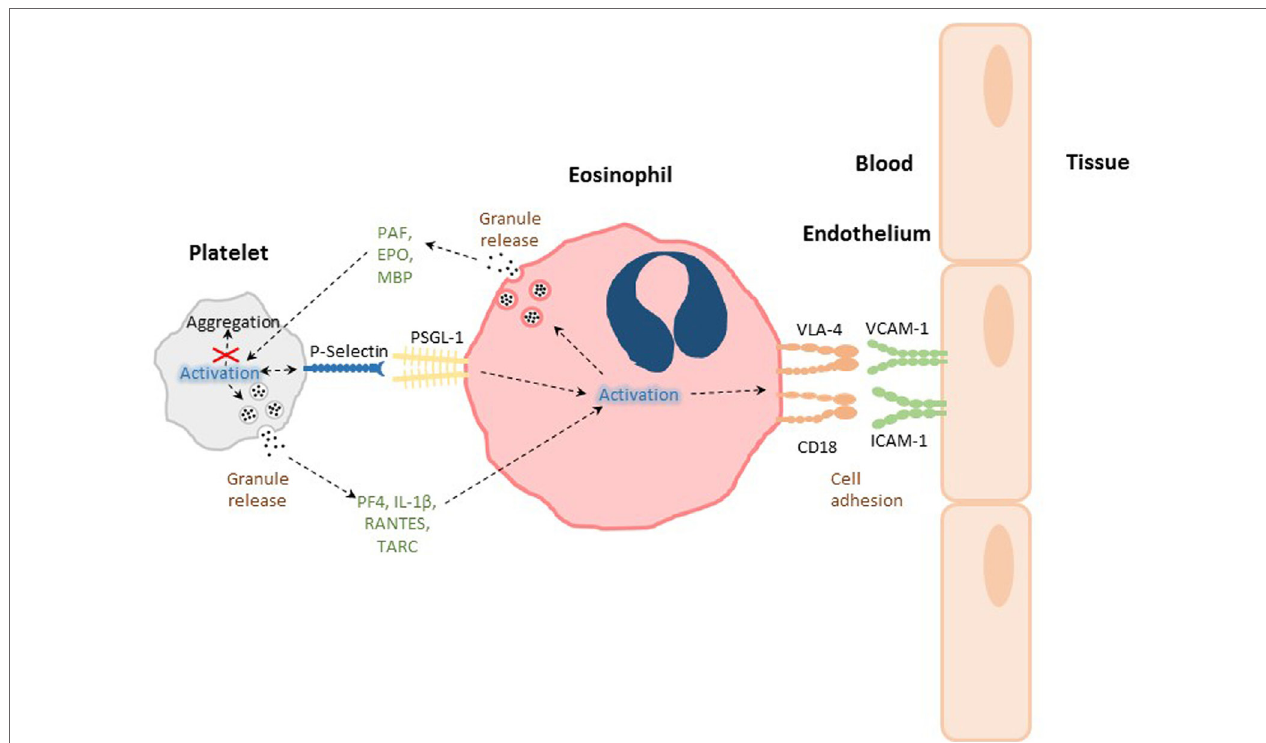
FiGURe 1 | The interactions between platelets and eosinophils. Platelets and eosinophils can directly interact with one another via both contact-dependent (e.g., P-selectin/PSGL-1) and soluble mediator-dependent [eosinophil: platelet-activating factor (PAF), eosinophil peroxidase (EPO), major basic protein (MBP); platelet: PF-4, RANTES, IL-1 β , thymus activation regulated chemokine (TARC)] mechanisms. The activation of platelets during allergic airways inflammation leads to platelet P-selectin-dependent eosinophil tissue recruitment, and activation eosinophils to express integrins very late antigen-4 (VLA-4) and CD18, or to release granule products. Granule constituents of eosinophils can likewise induce platelet activation and functions pertinent to inflammation and host defense, rather than aggregation, associated with intravascular thrombi